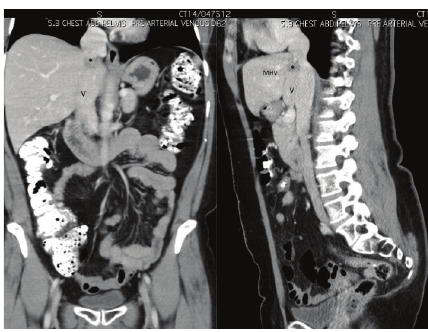
Figure 2: Coronal and sagittal reconstructed CT images showing theIVC(V)receivingtheMHV.Thesolitarymetastaticdeposit( ∗ )is seen in segment IVa at the junction of the hepatic-caval confluence.